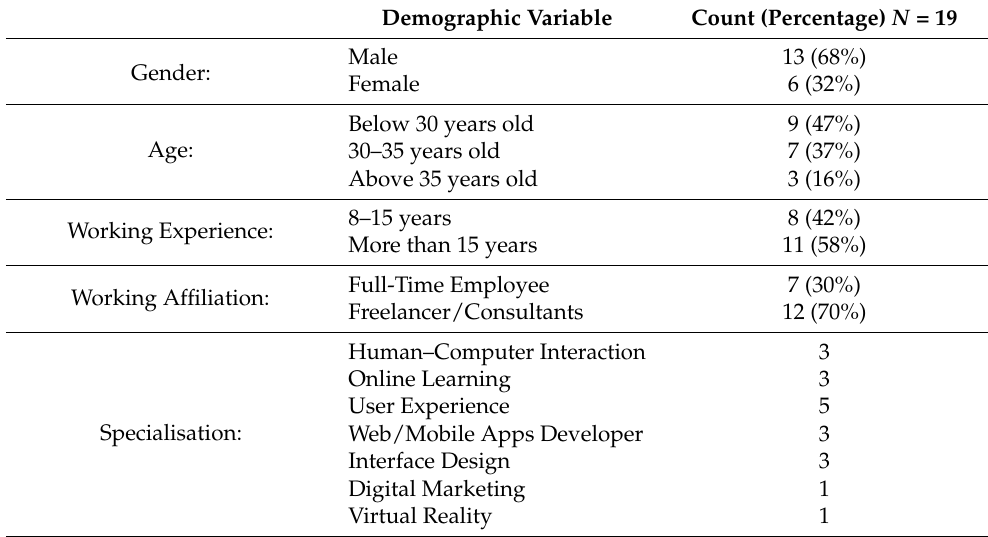
Table 2. Participants